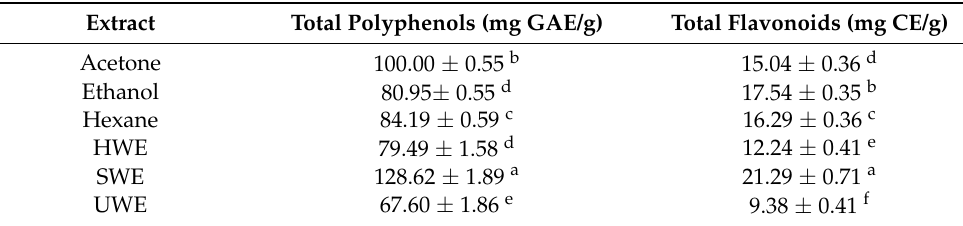
Table 2. Determination of total polyphenols and flavonoids in wheat germ